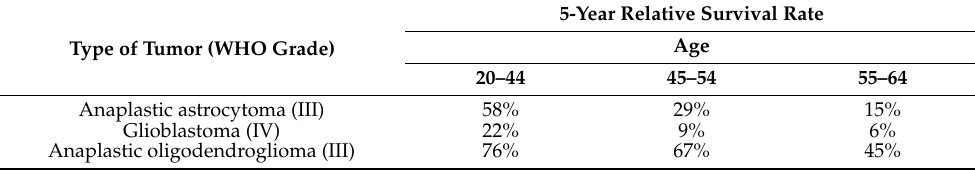
Table 1. 5-year survival rates for high-grade gliomas by age